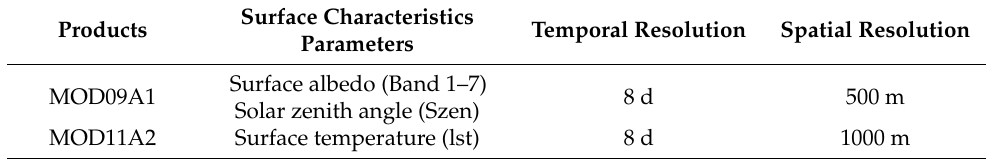
Table 1. Basic information on MODIS